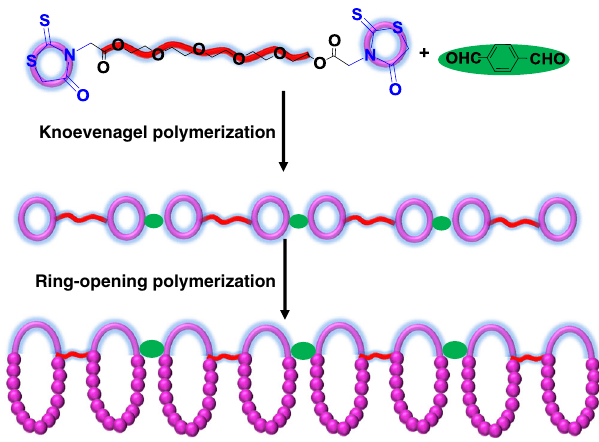
Fig. 5 Schematic illustration of the synthesis of linear multicyclic polymer. Linear polyrhodanine is produced by the Knoevenagel polymerization and acts as the ef fi cient macroinitiator to initiate the ring- opening polymerization of thiirane